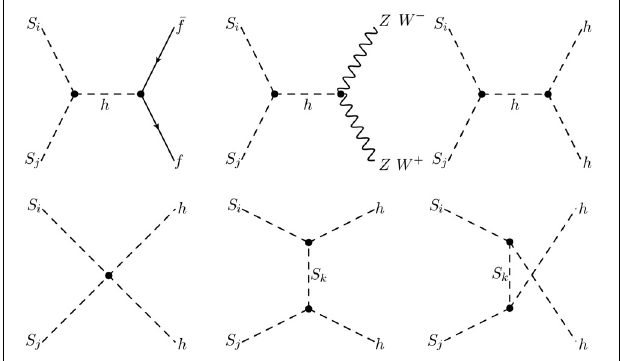
FIGURE 1 | Model’s Feynman diagrams present in the calculation of the relic abundance. This model provides the relic abundance, annihiliation and direct detection cross sections via the Higgs